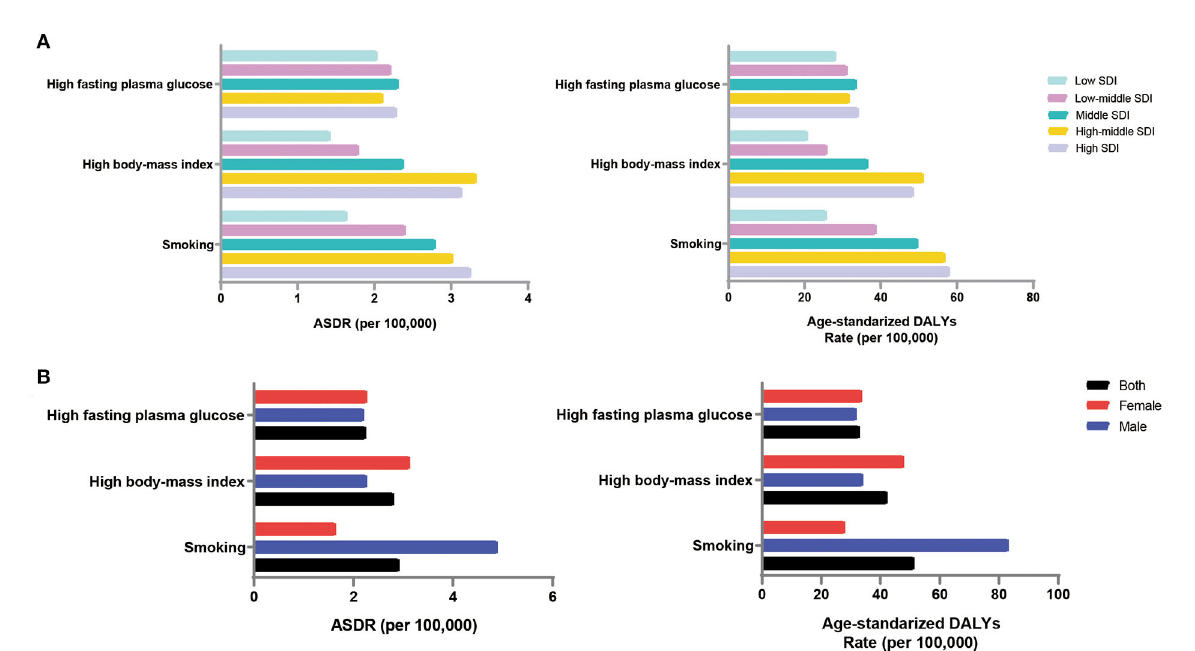
FIGURE5 Impact of risk factors on the disease burden of Alzheimer’s disease by SDI region and gender, 2019. (A) Contribution of three risk factors for death and DALYs in different SDI regions; (B) Contribution of three risk factors to death and DALYs in both sexes. ASDR, age-standardized death rate; DALYs, disability-adjusted life-years; SDI, sociodemographic